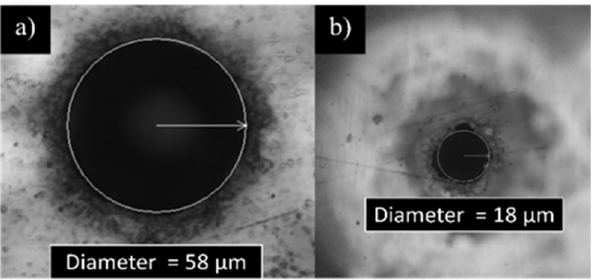
Figure 6. ( a ) Top and ( b ) bottom side of a fs-laser drilled pore on CA layer. The average dimensions are indicated.